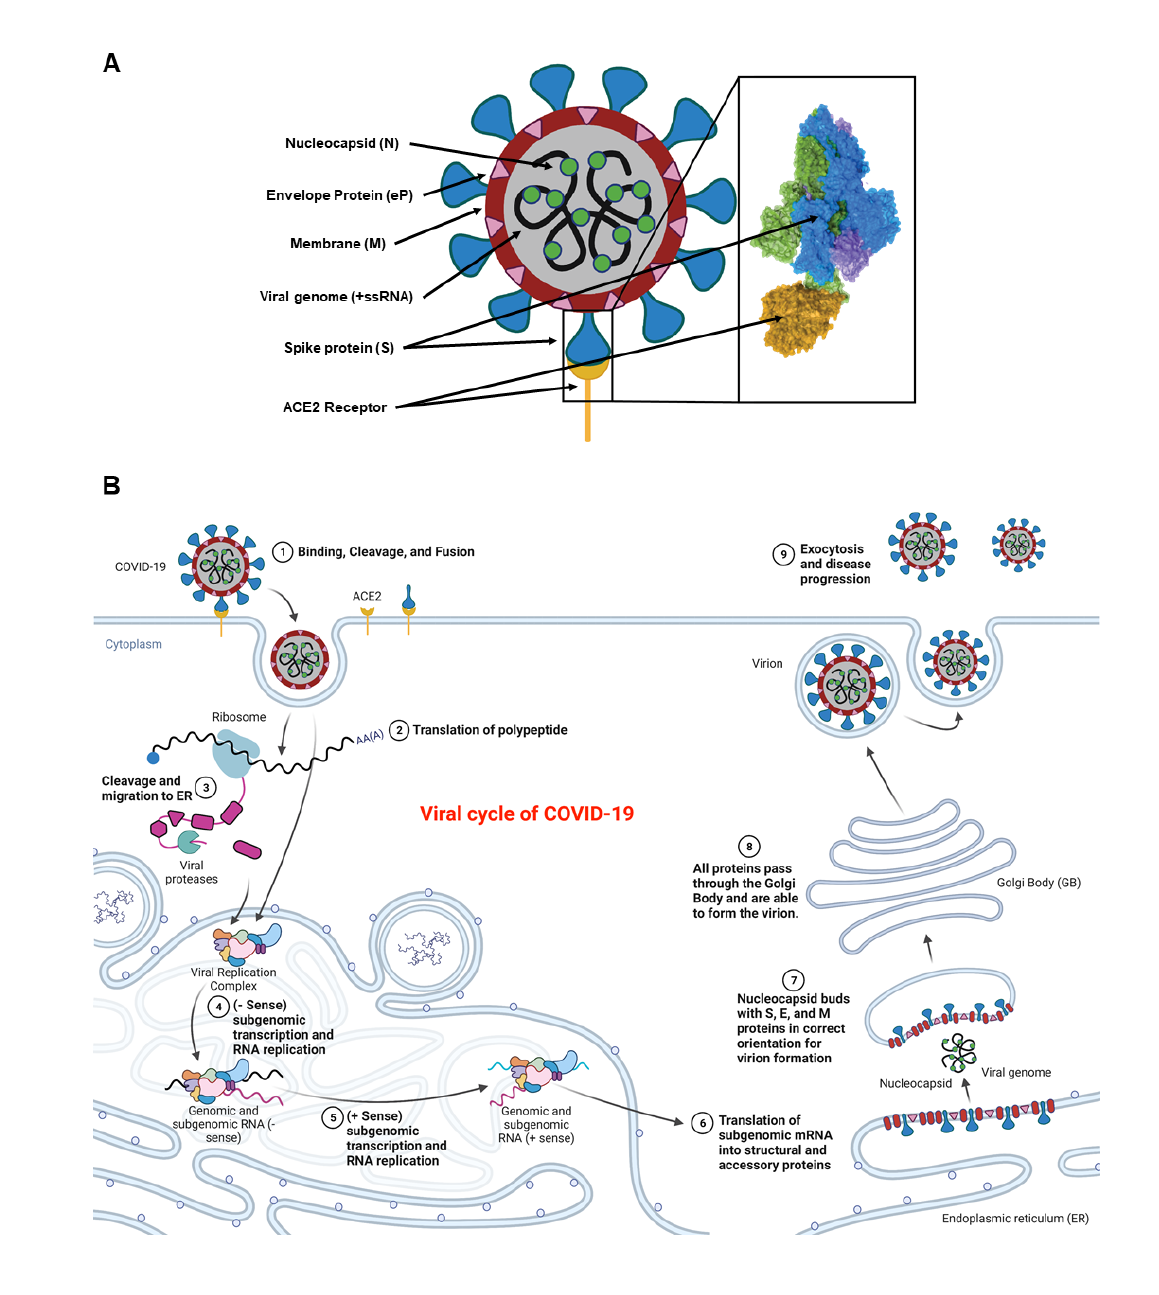
Figure 1: Schematic representation of a COVID-19 virus and its different components including the spike protein (blue), plasma membrane (red circle), nucleocapsid proteins (green circles), positive sense single stranded RNA (black lines), ACE2 receptor (yellow umbrella-shaped), and the envelope protein (pink triangles). The spike protein is further magnified to show various parts including the receptor bind- ing pocket and its binding to the ACE2 receptor (yellow) ( A ). Entry of the COVID-19 virus into a body cell upon binding, cleavage, and fusion to the ACE2 receptors. Initial +ssRNA is translated using host cellular machinery to make the viral replication complex within the host endoplasmic reticulum (ER). This complex is then used in conjunction with the +ssRNA to make -ssRNA copies that allow for genomic duplication. These duplicates are then translated to make all the virus specific proteins. The host ER then positions all viral proteins for subsequent migration to the Golgi Body (GB). As the vesicle is moved to the GB, it engulfs a copy of the +ssRNA viral genome and forms a virion ( B ). The virion is migrated to the plasma membrane where it is expulsed and can now infect new somatic cells or cells of another individual. Retrieved and revised from